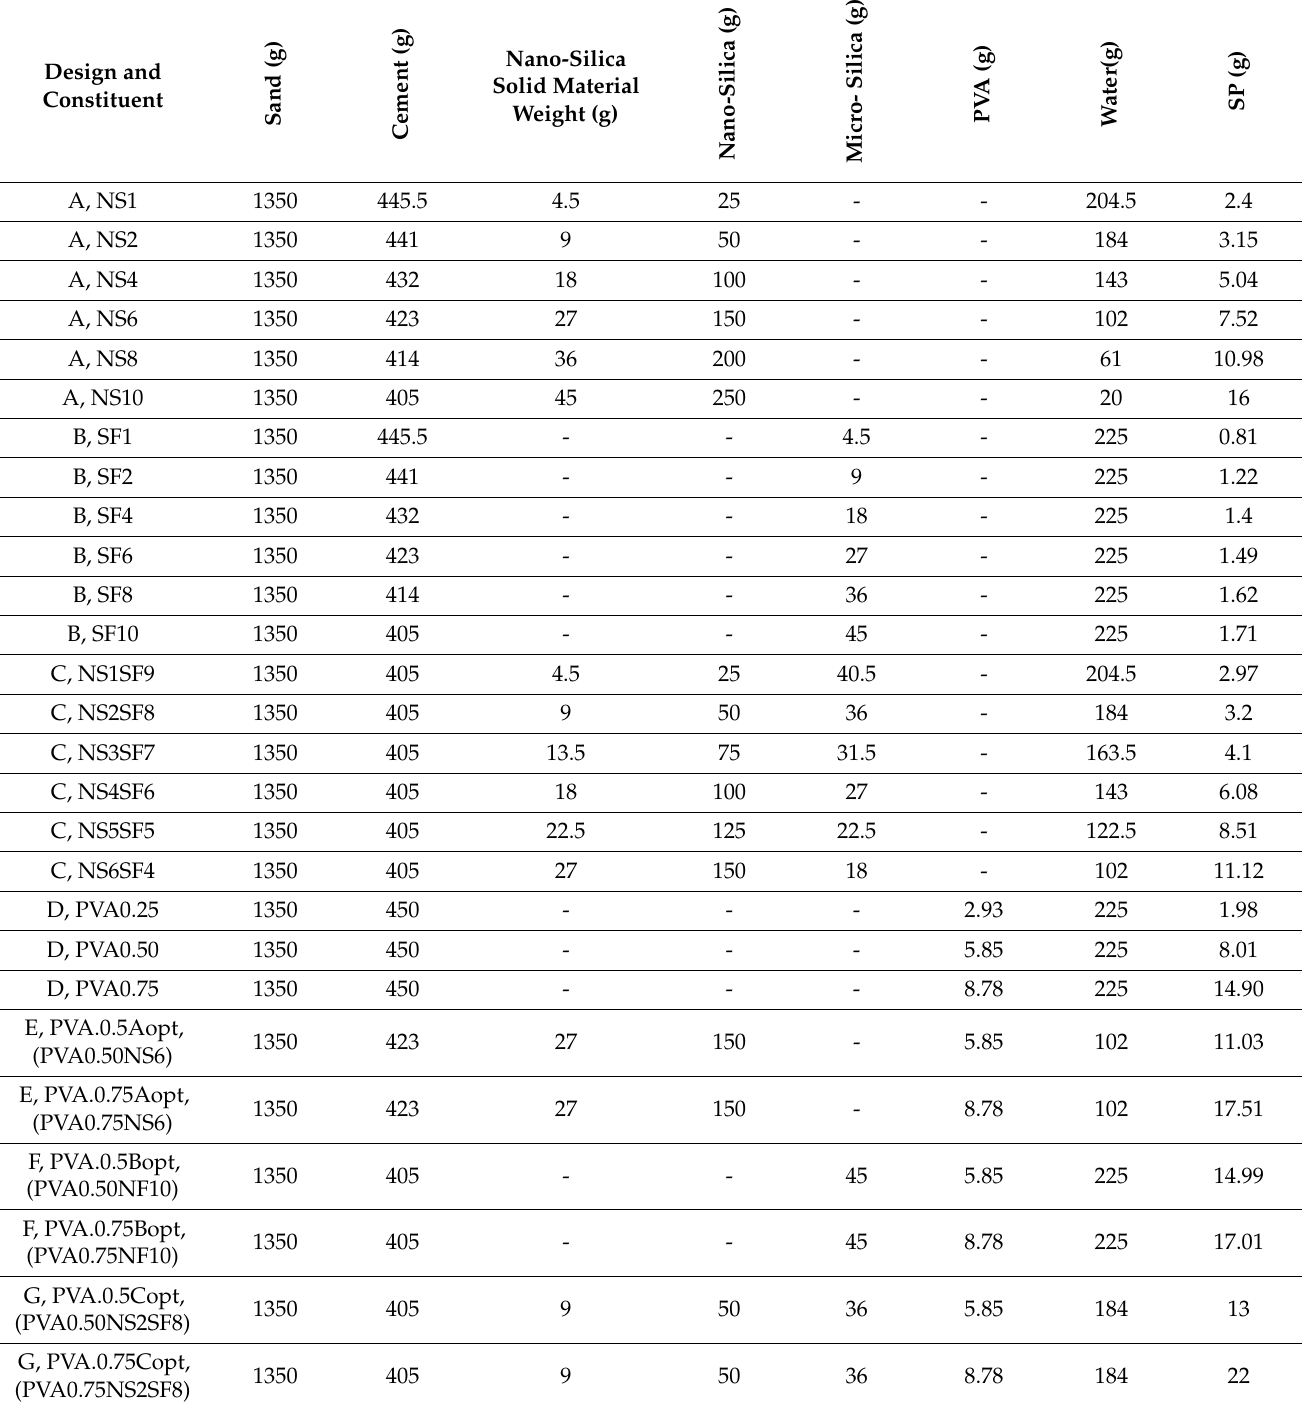
Table 5. Mix design